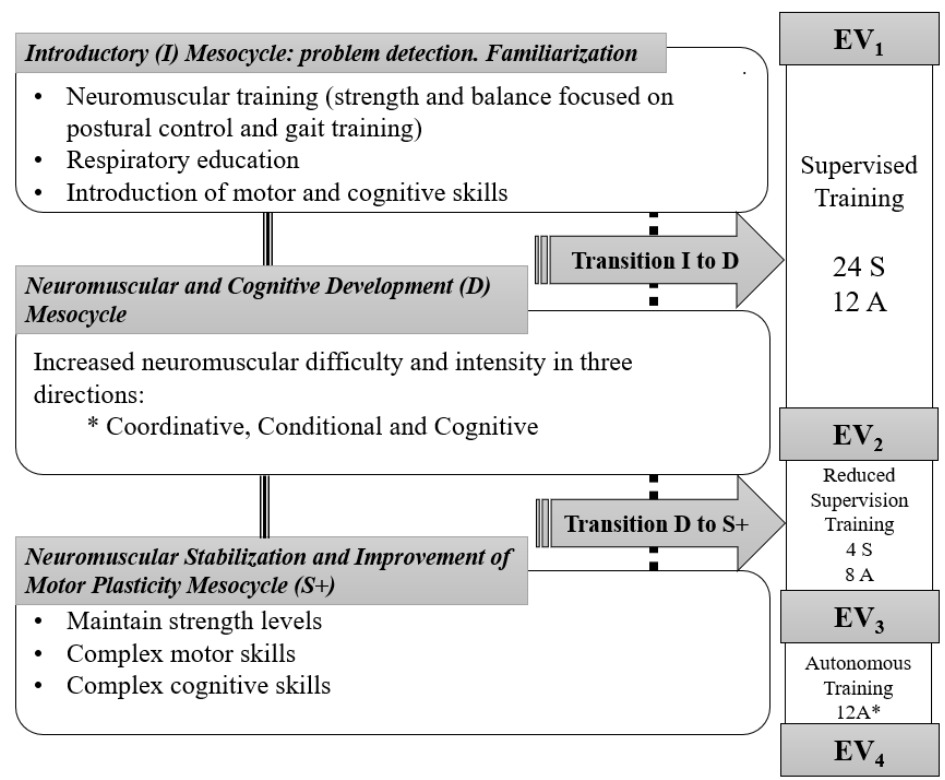
Figure 2. Phases and planning according to mesocycles of the training period. * During the autonomous phase. Telephone follow-up; uncertainty about the 3-weekly sessions completion in some subjects. Black line: training process; Dash line: training process when transitions were needed; S: Supervised sessions; A: Autonomous sessions.